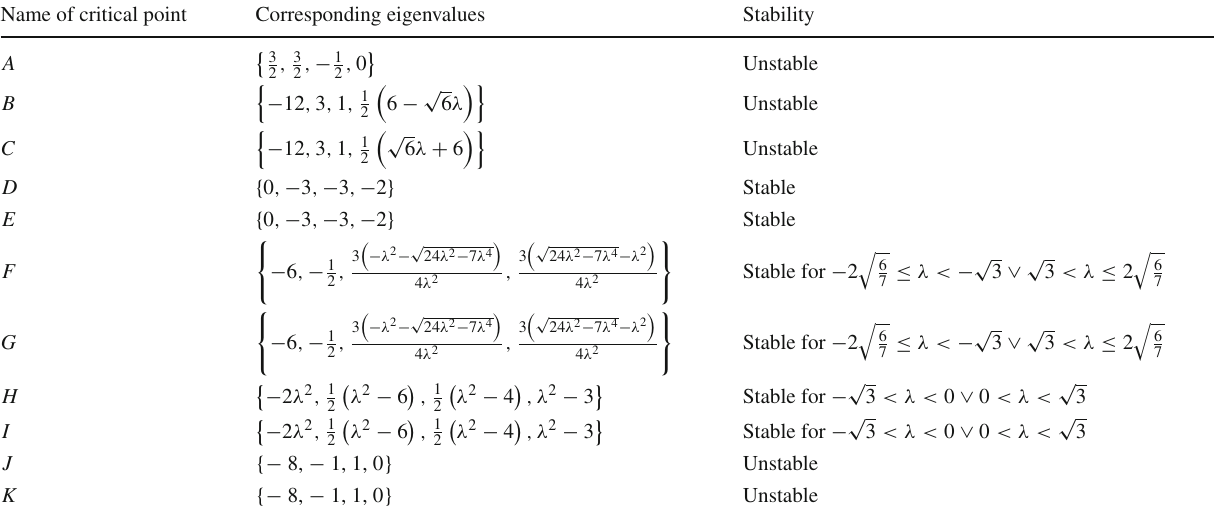
Table 6 Eigenvalues and stability of eigenvalue at corresponding critical point Name of critical point Corresponding eigenvalues